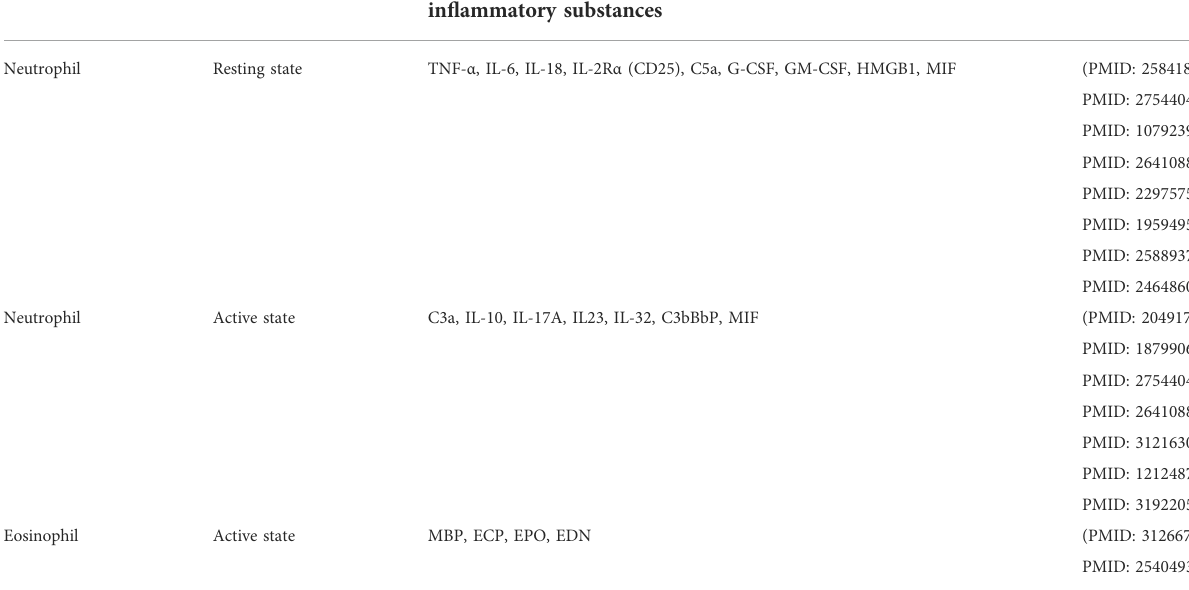
TABLE 1 Neutrophils/eosinophils and major in fl ammatory substances involved in the pathogenesis of ANCA-associated vasculitis (AAV). Cell